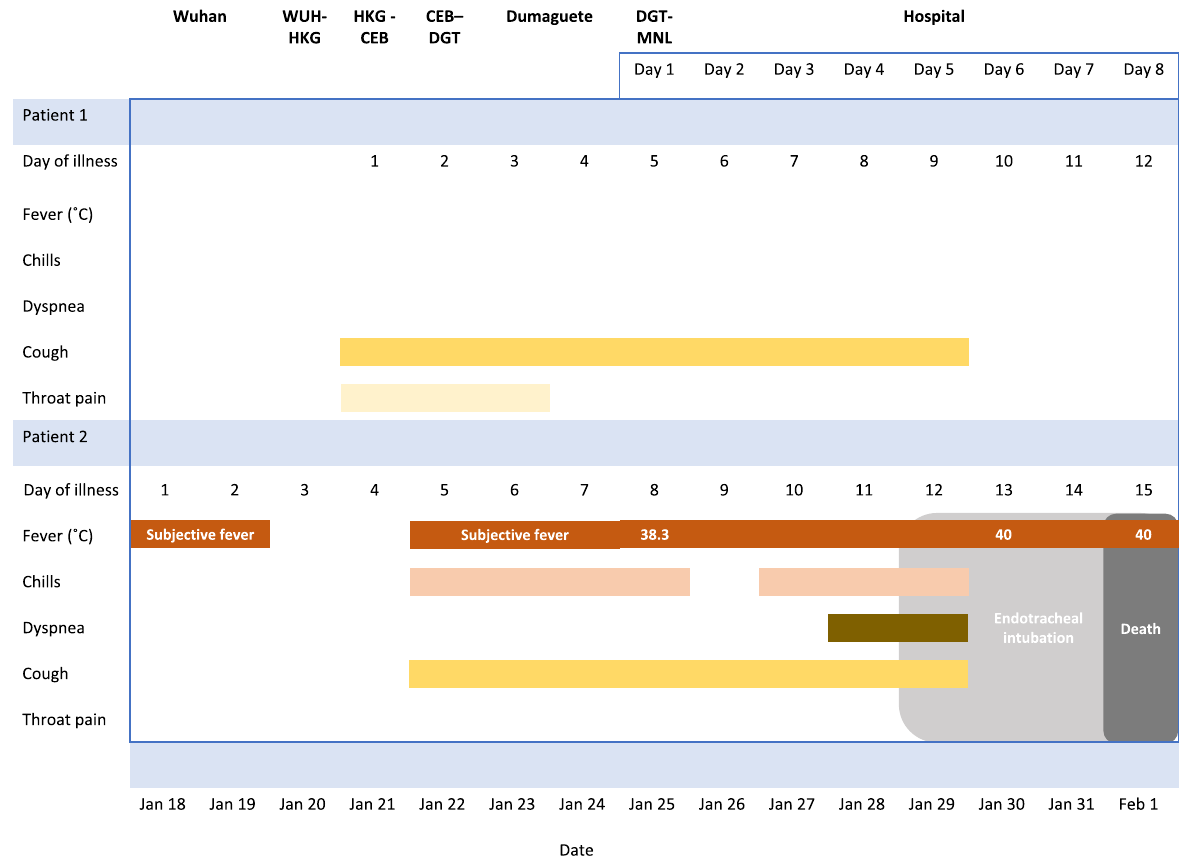
Fig. 1 Timeline of symptoms according to day of illness and day of